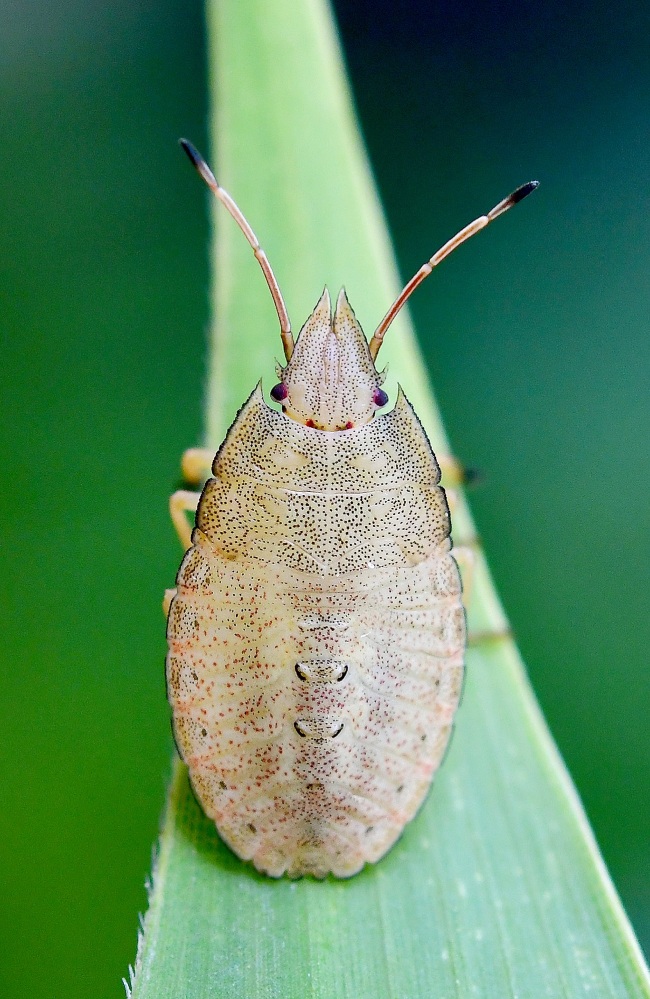
Fourth instar nymph.